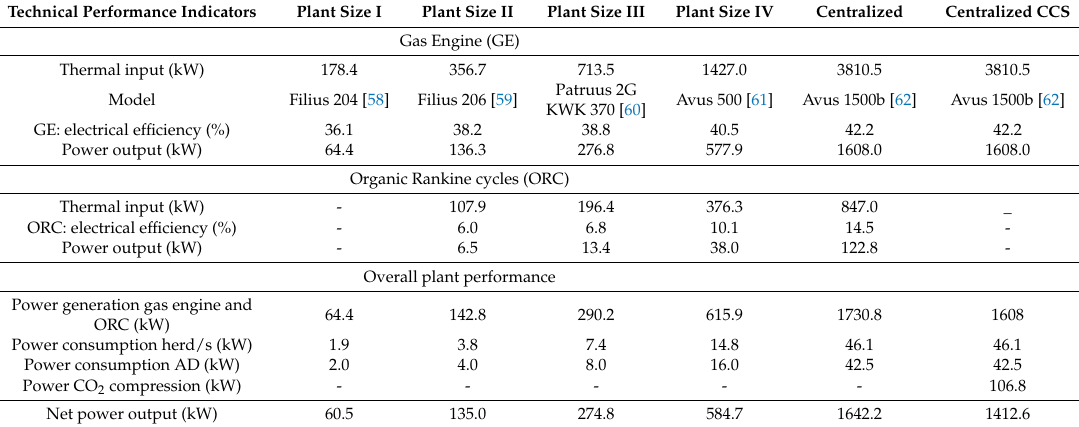
Figure 2. Specific electricity generated per kg VS. Table 4. Technical performance indicators for the different plant sizes and machinery.